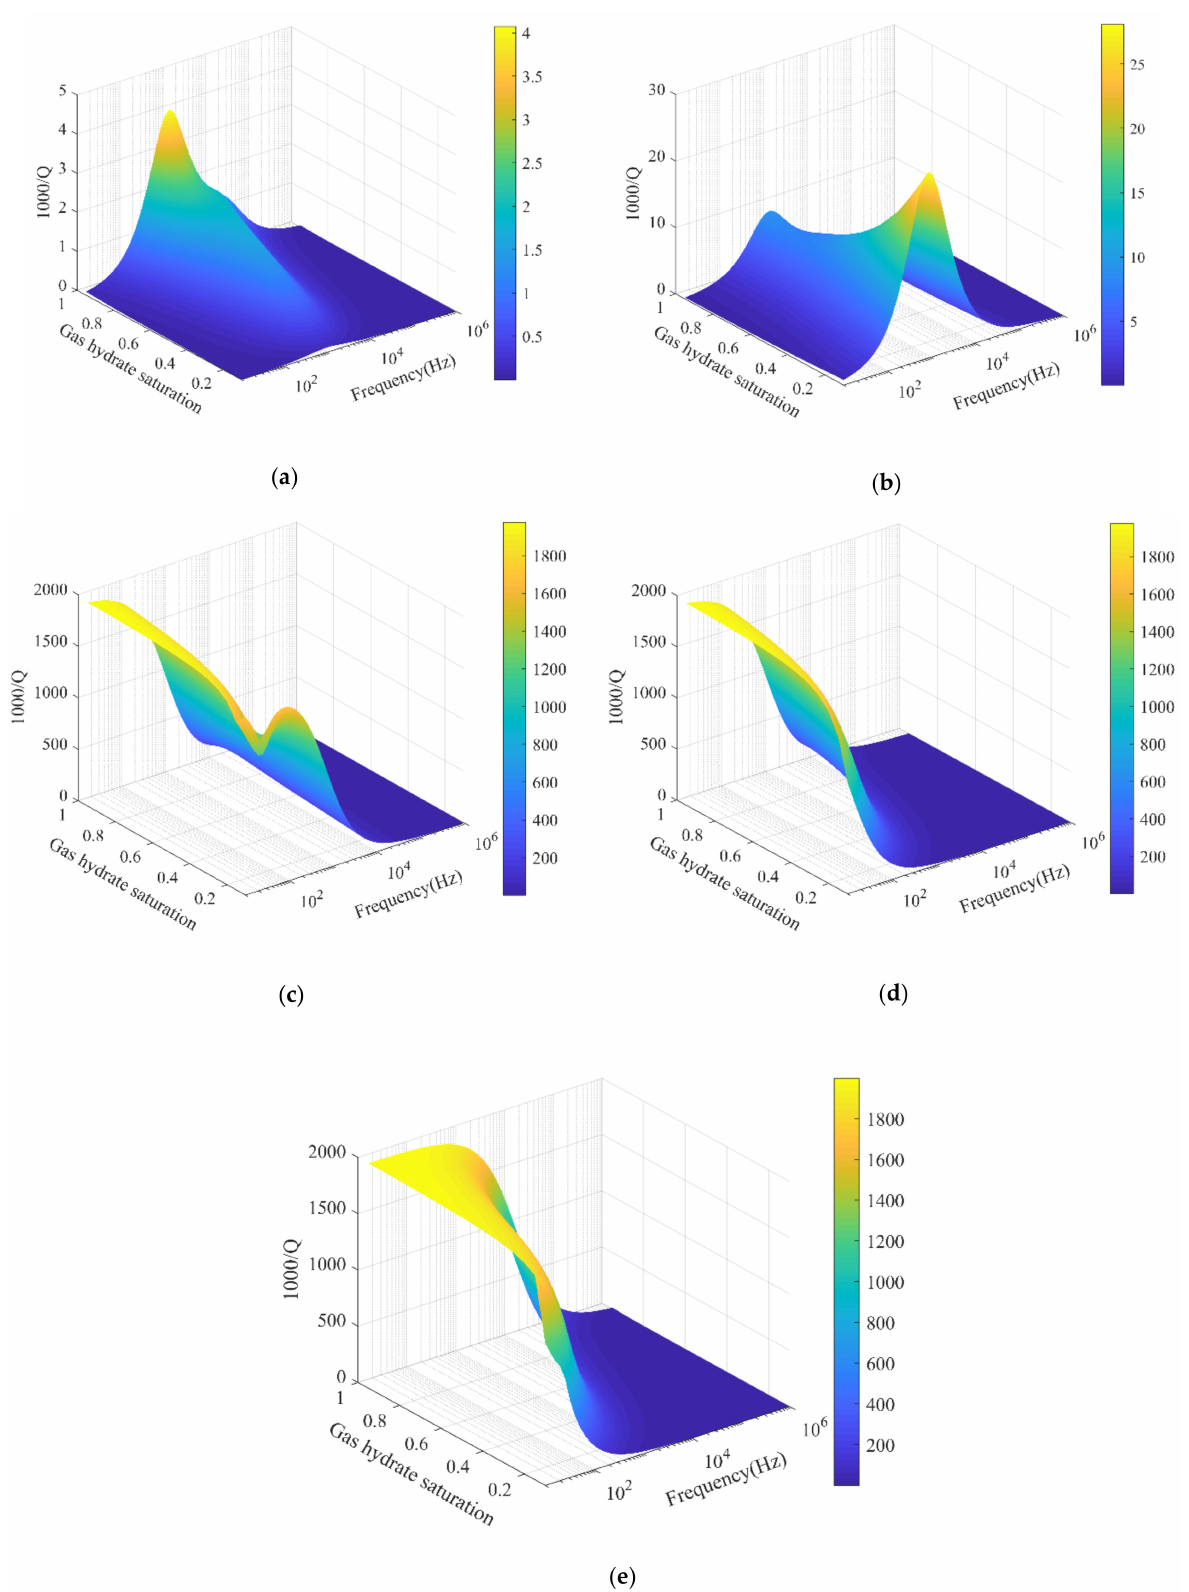
Figure 5. Effects of frequency and hydrate saturation on the attenuations of five waves: ( a ) P1; ( b ) S1; ( c ) P2; ( d ) S2; ( e )